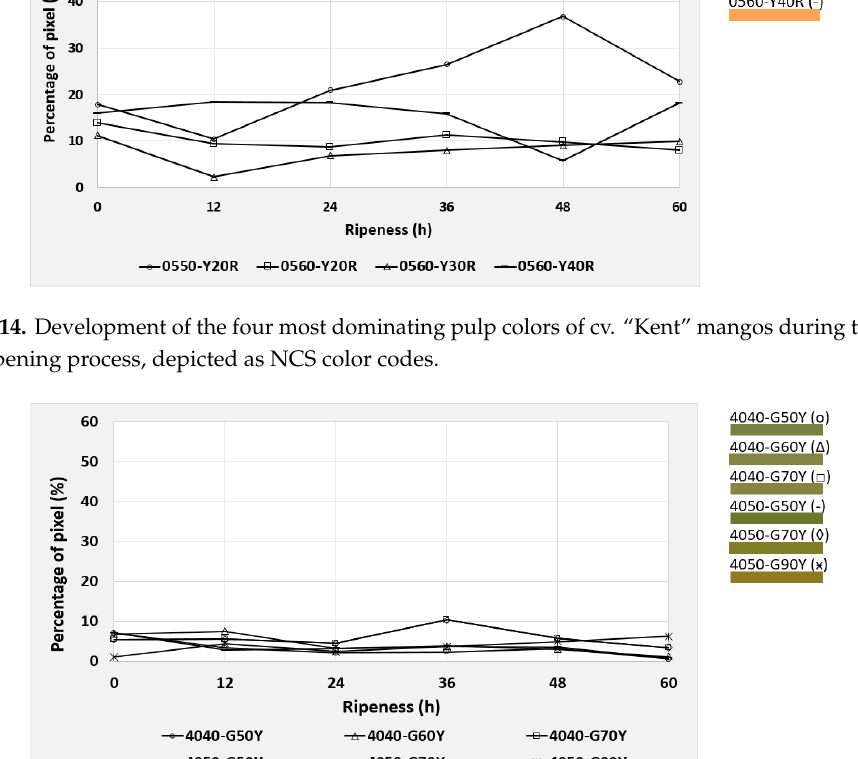
Figure 15. Development of the six most dominating peel colors of cv. “ Kent ” mangos during the 70 h post-ripening process, depicted as NCS color